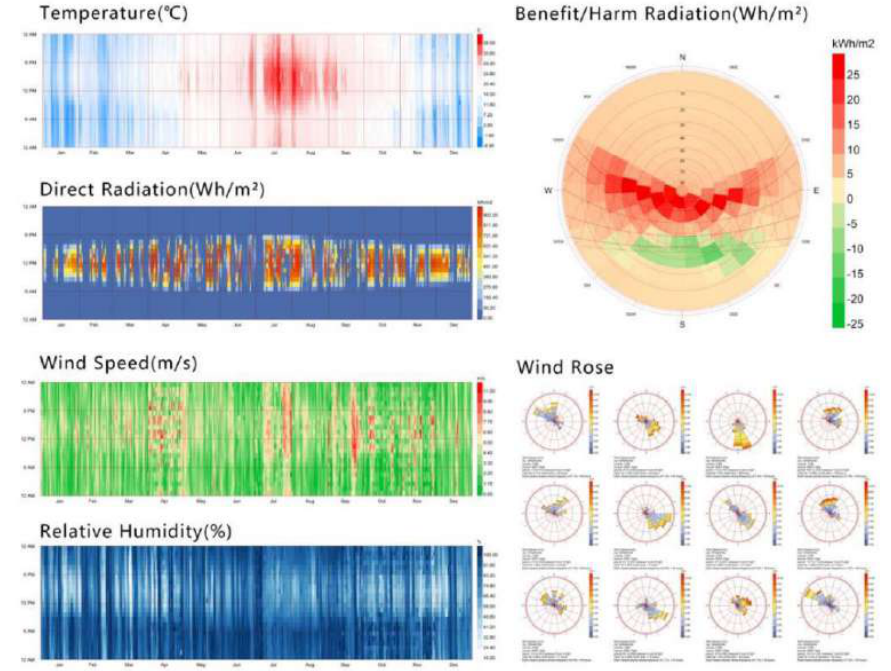
Figure 1. Ladybug Tools (EPW file) were used to collect Shanghai’s climate data.